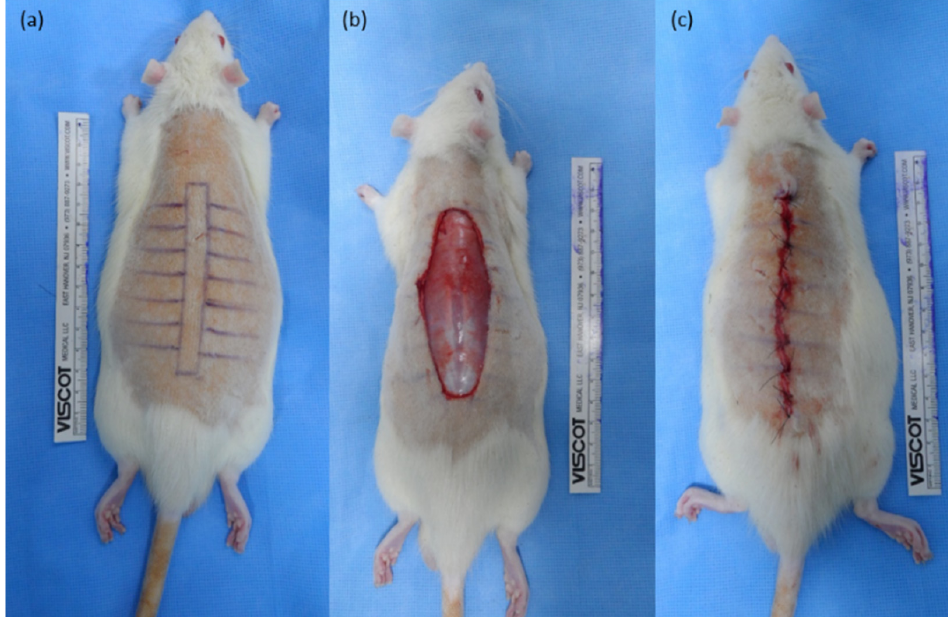
Figure 8. Rat incisional scar model. ( a ) An 8 × 1 cm 2 rectangular cut was made on the dorsal skin of a male Sprague–Dawley rat; ( b ) The entire skin and muscle were excised; ( c ) The skin layer was sutured, leaving the muscle layer unsutured to maximize the tension in the skin